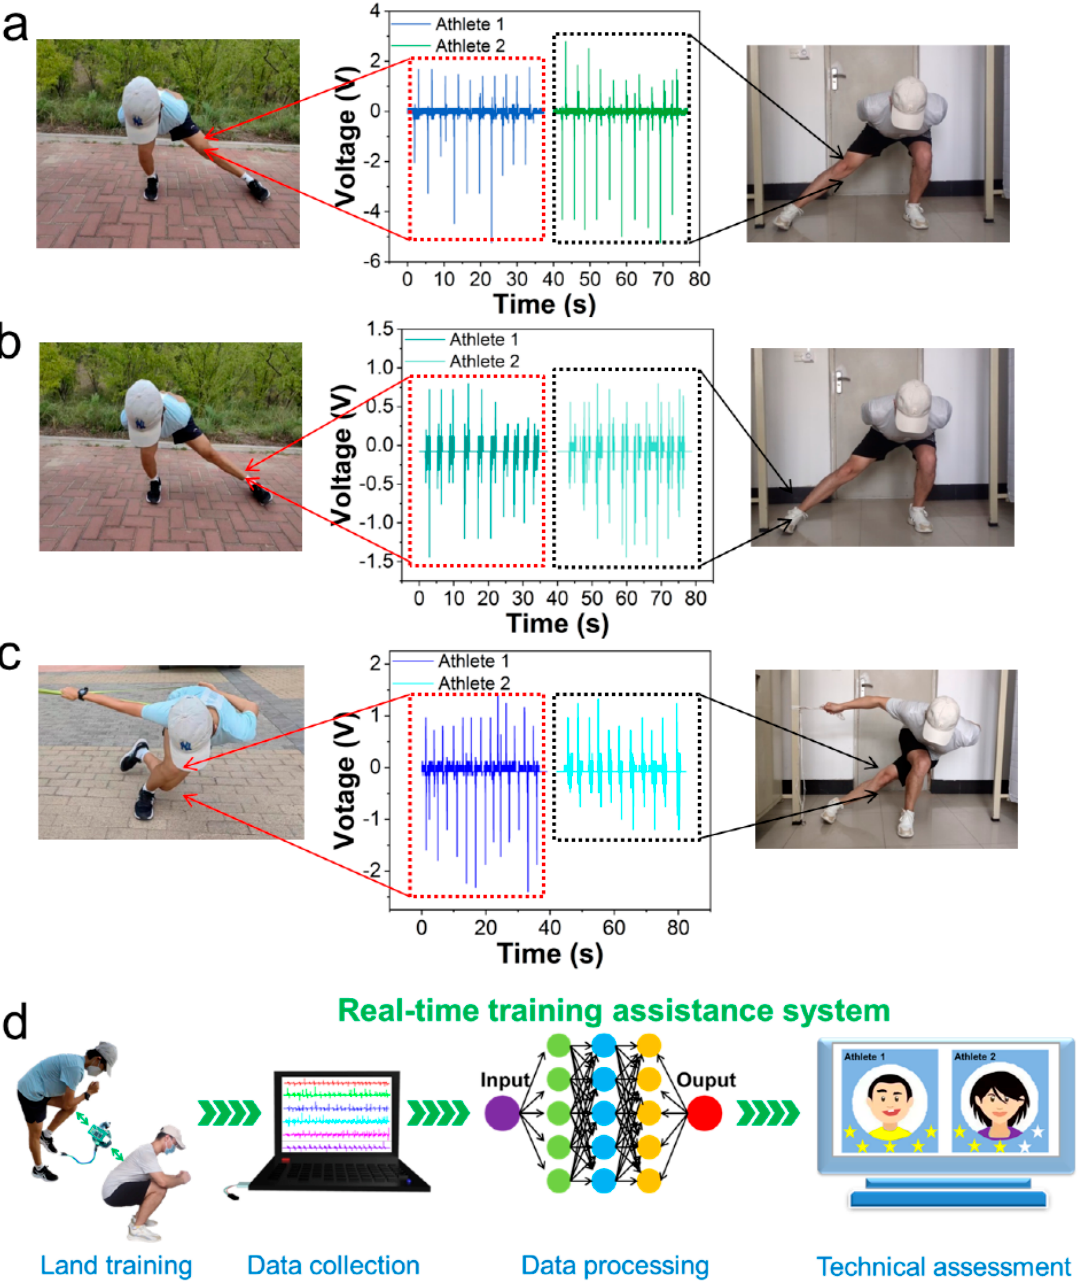
Figure 5. Application of SD-TENG in land training ( a ) Knee output voltage diagram of land training side stirrup exercise. ( b ) Ankle output voltage diagram of land training side stirrup exercise. ( c ) Knee joint output voltage diagram of the belt traction simulation training. ( d ) The operating diagram of the speed skating land training assistance system.